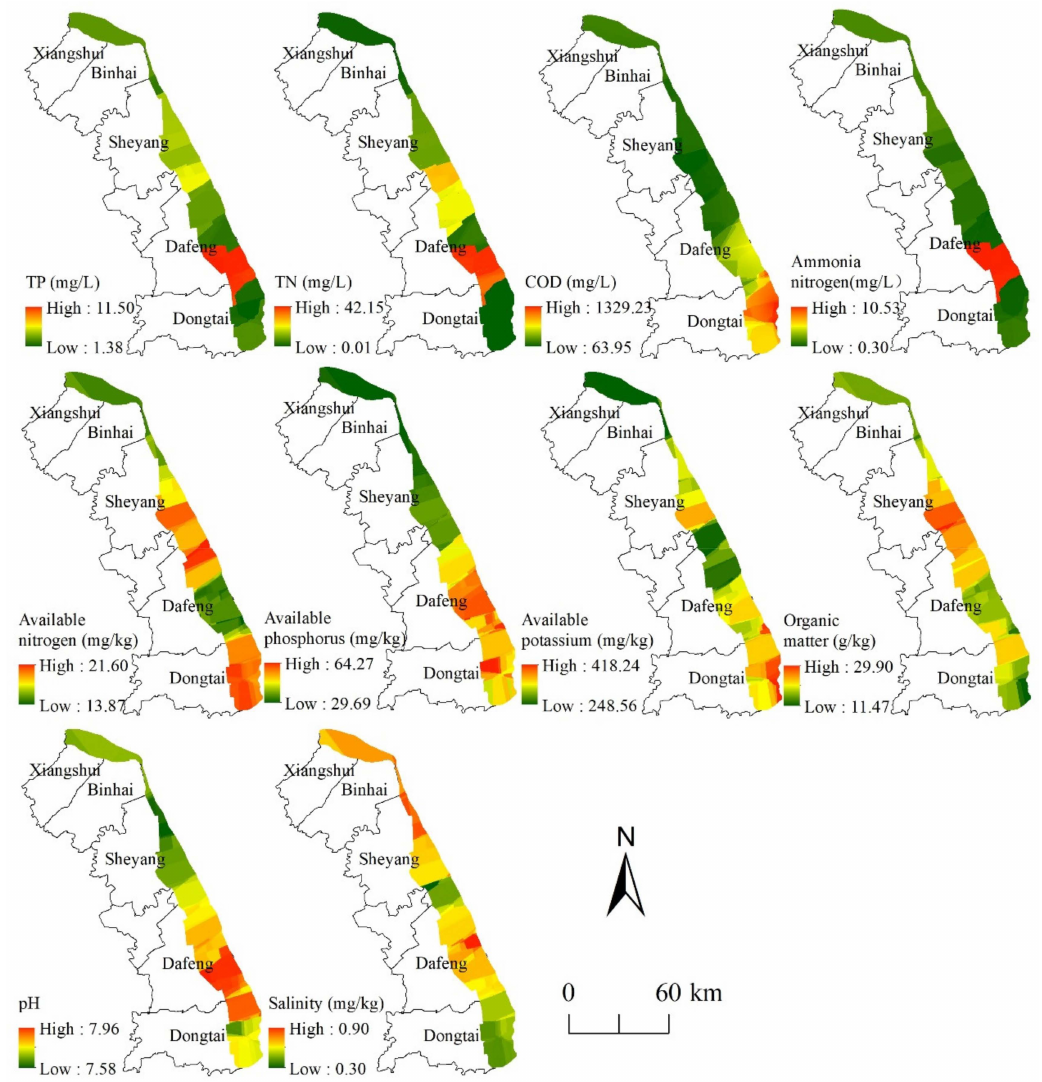
Figure 2. Spatial interpolation results of water quality (TP, TN, COD and Ammonia nitrogen) and soil (Available nitrogen, Available phosphorus, Available Potassium, Organic matter, pH and Salinity)